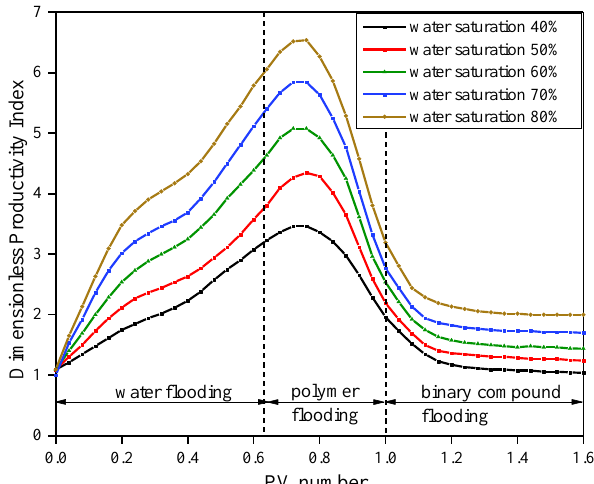
Figure 4. The variation in the dimensionless productivity index with the PV number injected under different water saturations.